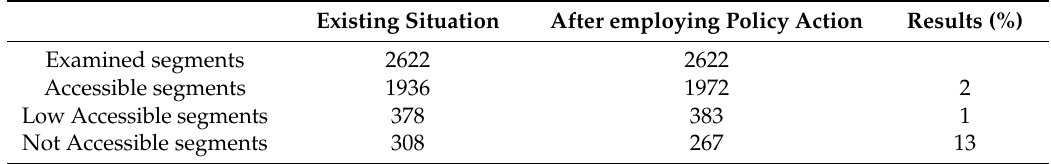
Table 6. The results of the policy change “3” on sidewalk accessibility.